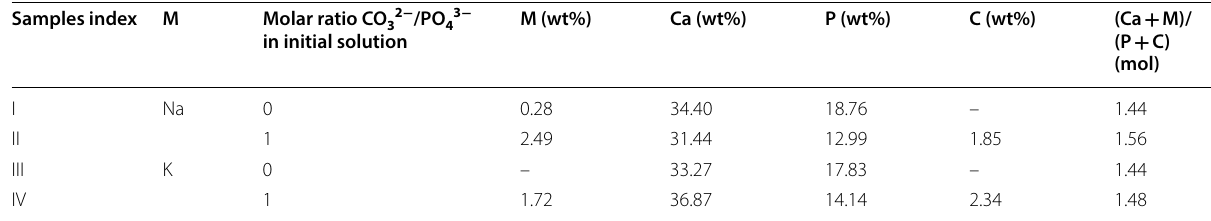
–CO 32 − –PO 43 − (M–Na, K) (at 3 −